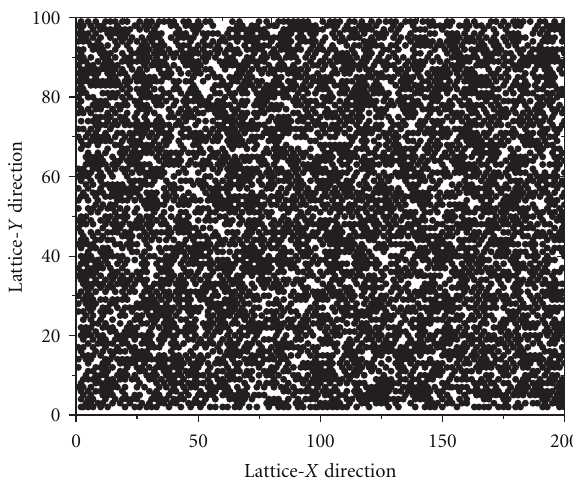
Figure 8: The figure shows micrograph of minority compo- nent after 30,000 Monte Carlo cycles (NVT-2D simulation). The Metropolis algorithm has been used in a self developed program with lattice size as 200 × 100 with 70%:30% compositions of the preferred and unpreferred components. The majority component has strong a ffi nity to the two confining substrates and the minority experiences strong repulsive force field of the two substrates. Periodic boundary condition is applied in X direction. Program has been developed by the author in